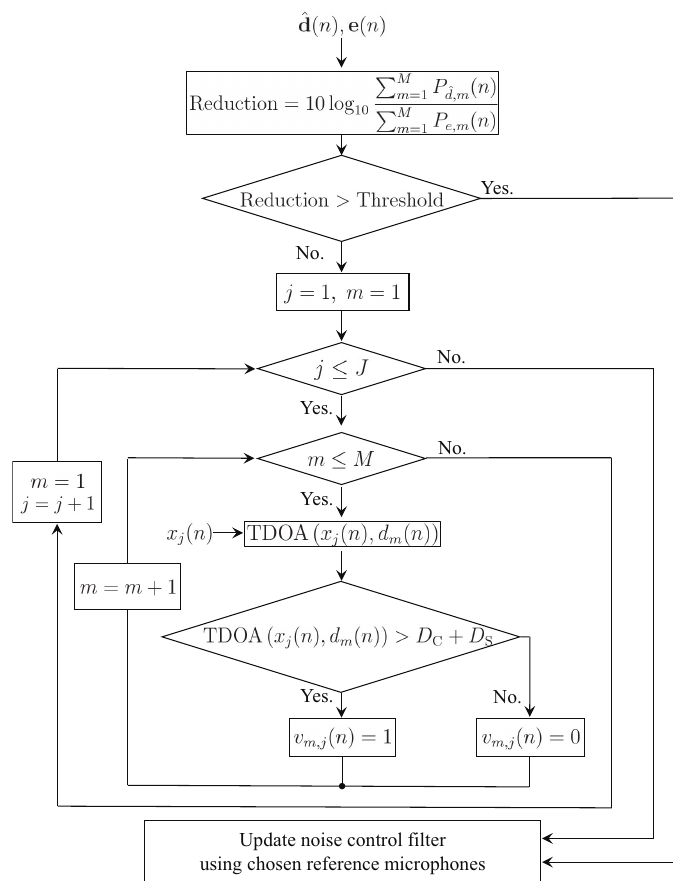
Figure 5. Flow chart of the reference microphone